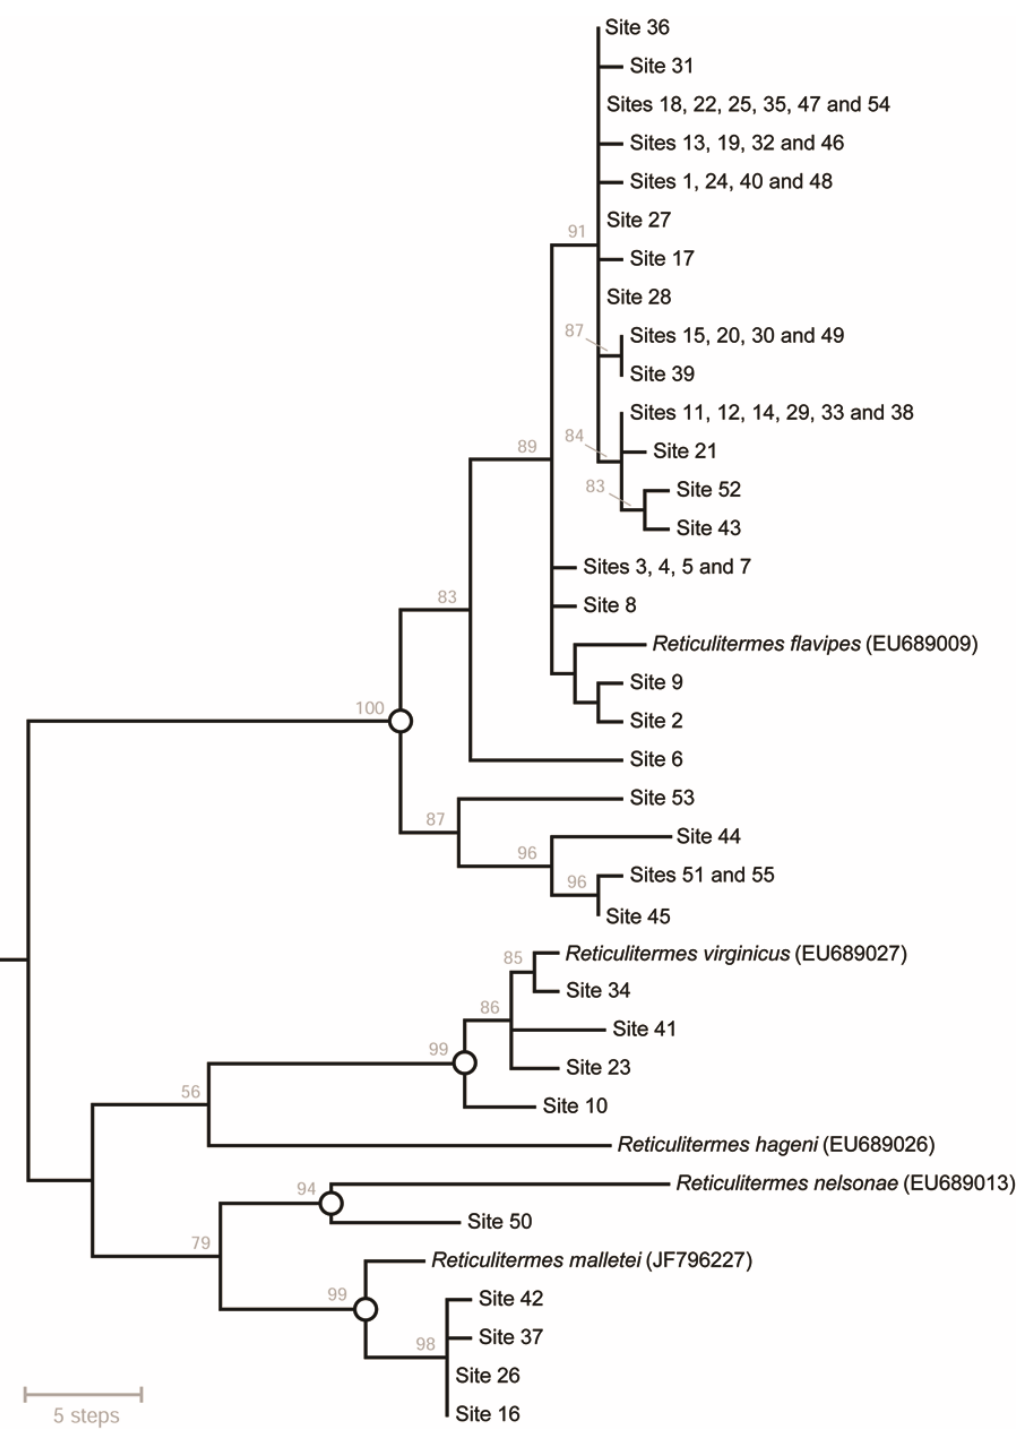
Figure 2. Phylogenetic relationships among Reticulitermes mt COII sequences from 55 new and five reference specimens ( n = 37 non-redundant haplotypes; 607-bp alignment), estimated using Maximum Parsimony. Shown here is a 50% majority-rule consensus tree of eight equally-parsimonious trees (length = 166 steps). Tip labels indicate the geographic location(s) from which a termite with a given DNA sequence haplotype was sampled (Figure 2; Table S1). Numbers above nodes are bootstrap support values. Open circles on nodes mark the most inclusive well-support clades that contain only one reference taxon (the same groups were recovered using Maximum Likelihood; Figure